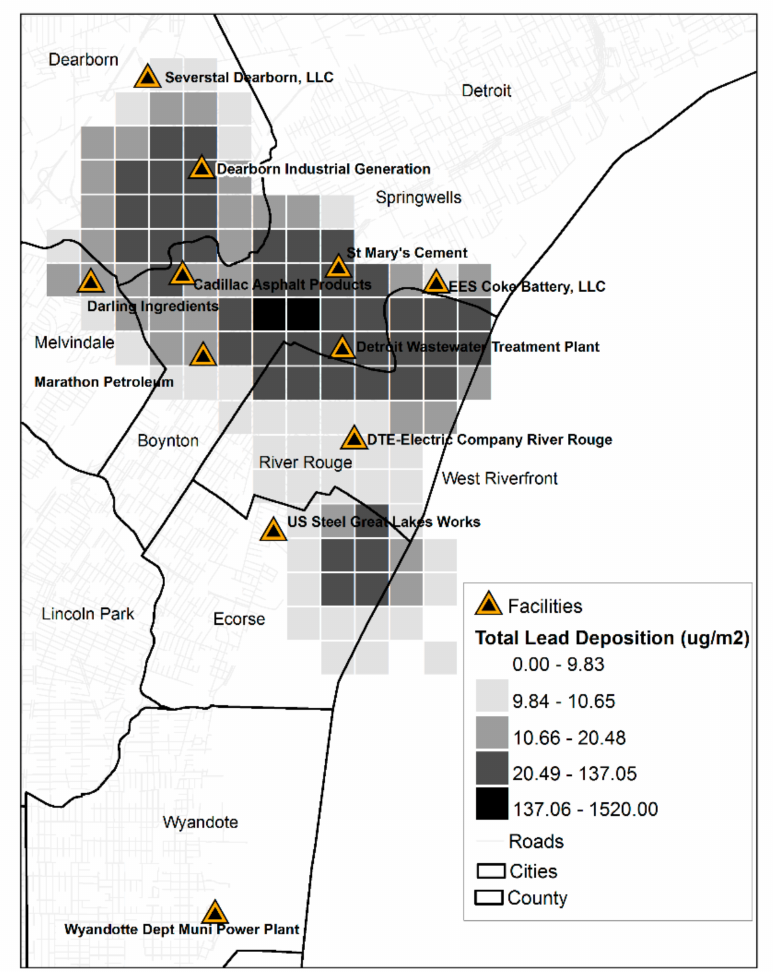
Figure 8. Total lead deposition in Southwest Detroit and surrounding suburbs,